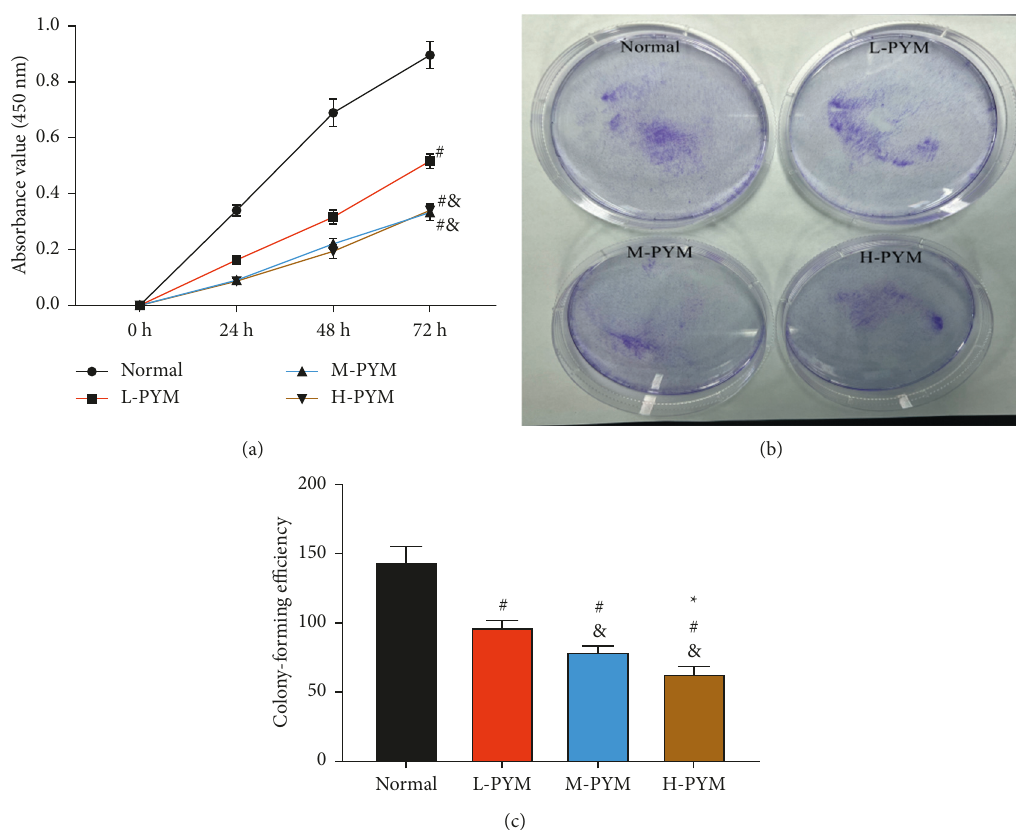
Figure 2: Impacts of PYM on OC cell activity. (a) Cell growth curve. (b) Experimental results of colony formation assay. (c) Colony-forming efficiency. Compared with the normal group, # P 0 . 05.